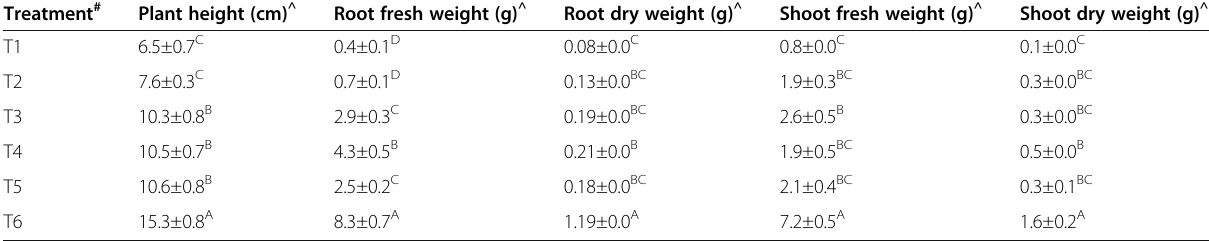
Table 3 Effect of Bacillus aryabhattai KMT-4 on plant growth after 45 days of treatment in pot experiments on brinjal ( Solanum melongena